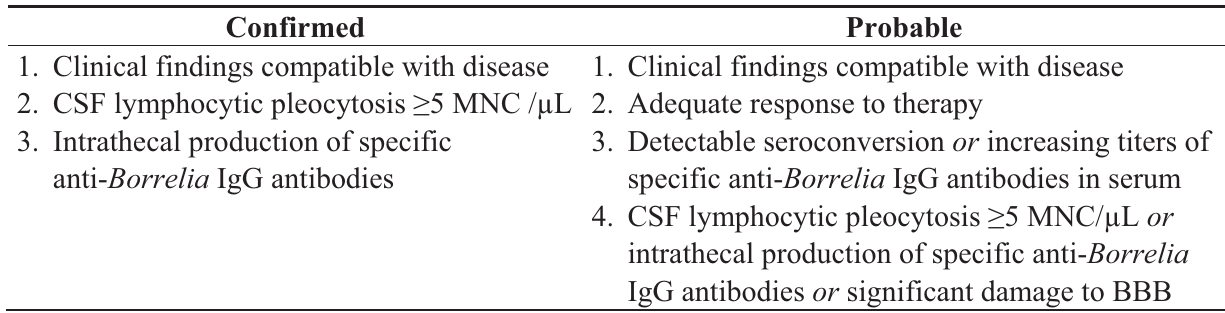
Table 3. Case definitions of Lyme